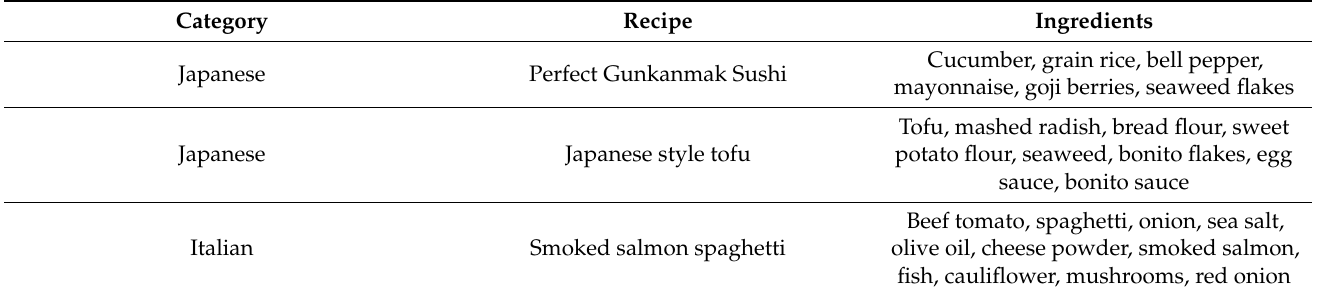
Table 9. Recipes in Group D that contains higher proportions of dietary